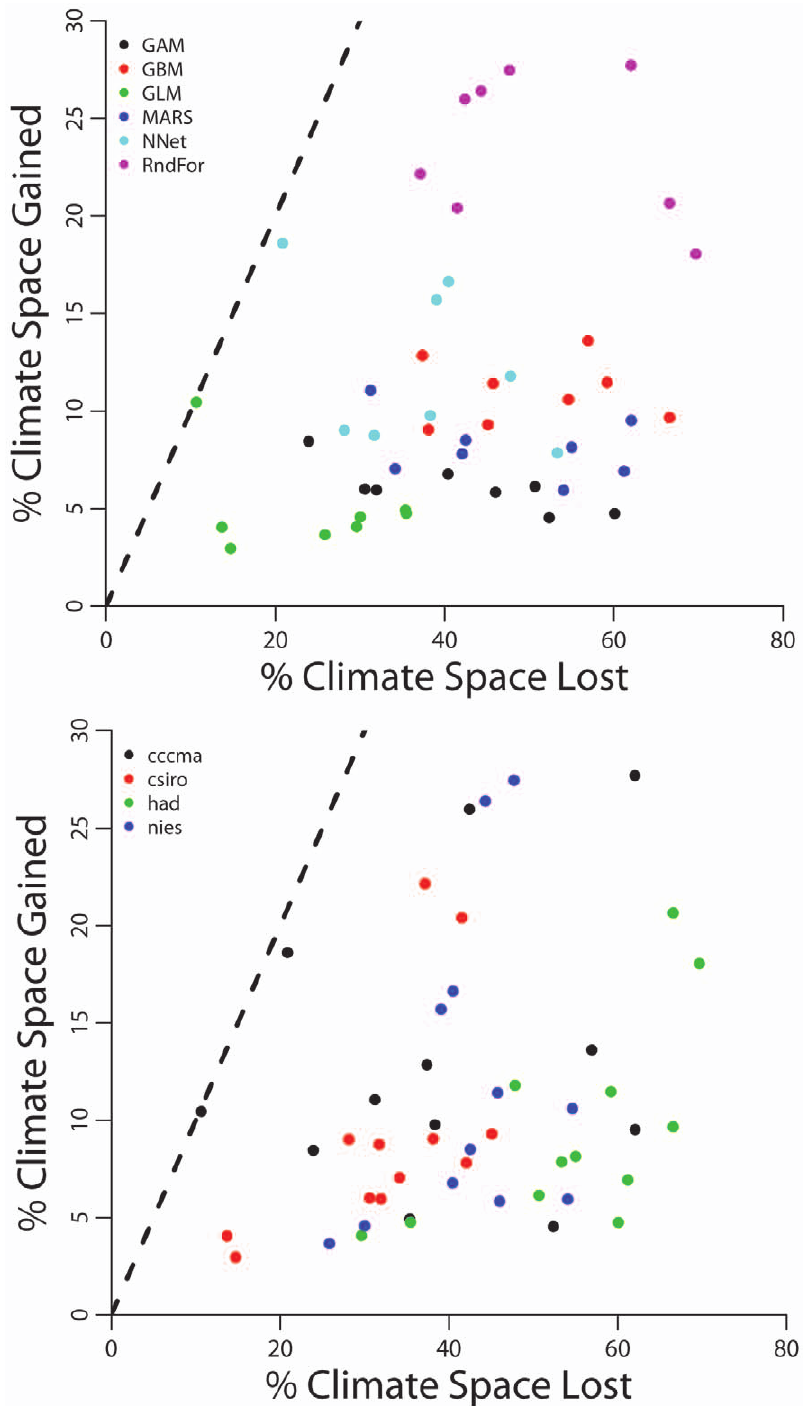
Figure 3. Proportion of climatically suitable sites (grid cells) that may be lost or gained by marsupial species in Brazil, according to six modeling methods (Generalized Additive Models, GAM; Generalized Boosting Regression Models, GBM; Generalized Linear Models, GLM; Multivariate Adaptive Regression Splines, MARS; Artificial Neural Networks, ANN; and Random Forest) and four climate models (CGCM3, MK2, HadCm3, NIES99). Values are median percentages of grid cells lost or gained for all marsupial species in a consensus of green house gases emissions scenarios (B2a and A2a). The line indicates what is expected if gains or losses of climatically suitable sites were proportional and happen by chance.